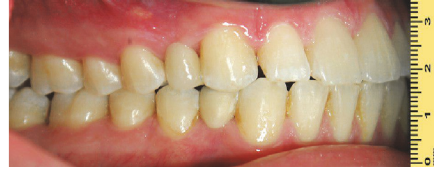
Figure 6: Resin-bonded-restorations delivery